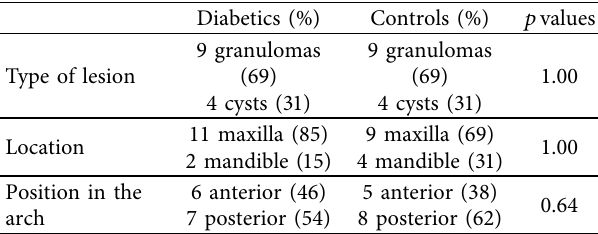
Table 1: Distribution of diferent variables from the diabetic and control